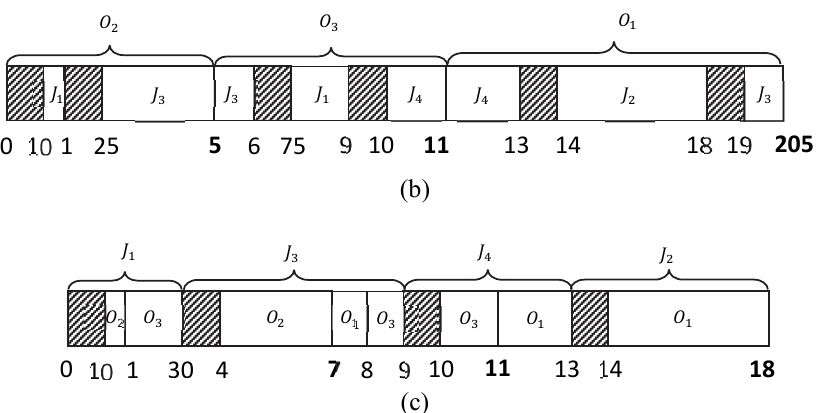
Fig. 1. Gantt chart for the extreme processing approaches: (a) order-based processing without setup savings; (b) order-based processing with setup savings; and (c) job-based